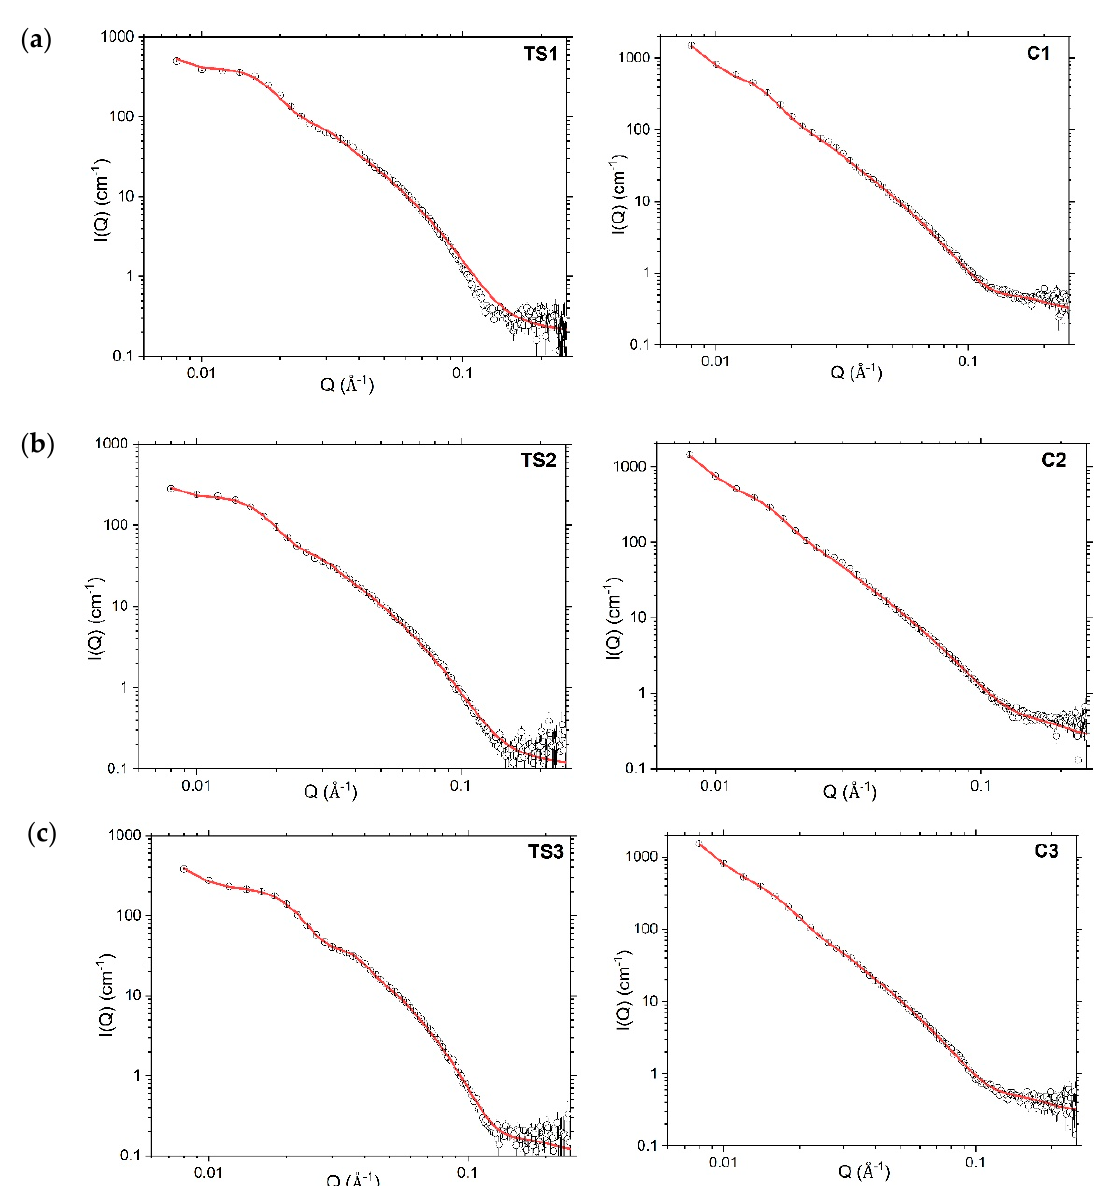
Figure 5. Model-fitted SANS profiles (red lines) recorded at 298 K for 4% ternary systems (TS) (left; Model A1) and creams (C) (right; Model B) prepared with a 1:1 ( a ), 1:0 ( b ) or 0:1 ( c ) ratio of hexadecanol:octadecanol co-surfactants. Error bars on the measured data are subsumed within the plotted symbols. Formulation compositions are provided in Methods, Table 1.